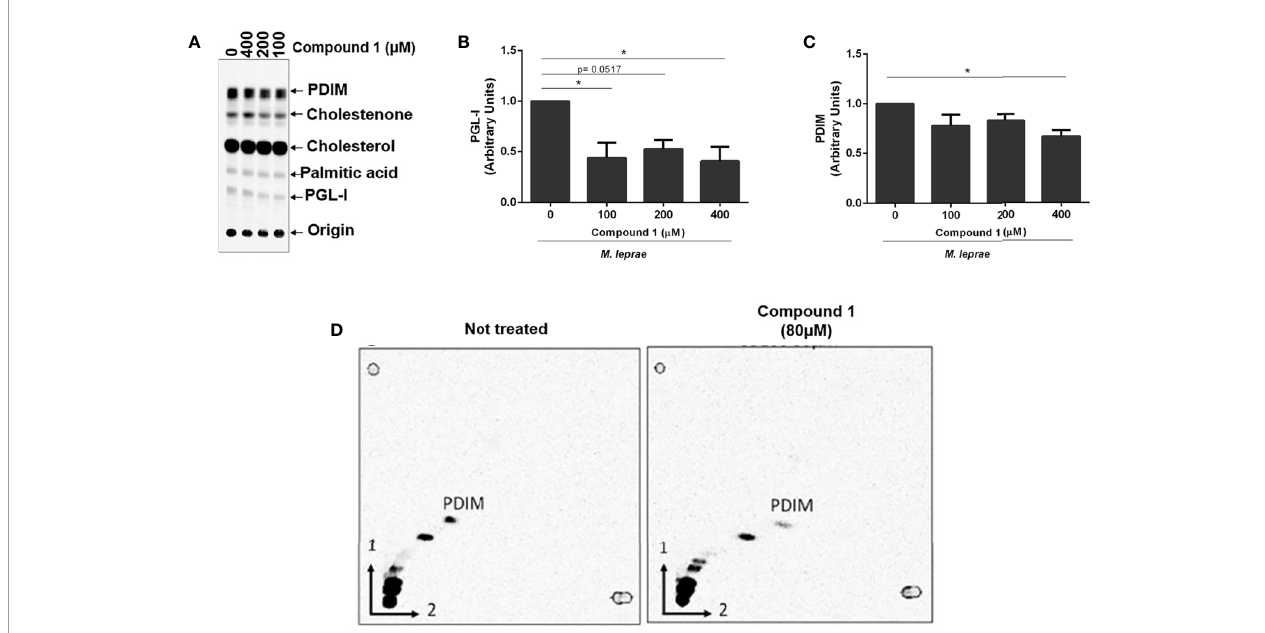
FIGURE 5 | Reductive power generated by 3 b -HSD supports PGL-I and PDIM synthesis. (A) TLC of lipid extracts from M. leprae treated with compound 1, representative of 4 experiments. TLC was resolved using chloroform-methanol 95:5 (v/v) as mobile phase. Standards: PDIM, cholesterol; cholestenone; palmitic acid and PGL-I. Corresponding densitometry of PGL-I (B) and PDIM (C) (*p < 0.05 - ANOVA test followed by Bonferroni post-test were performed for statistical analyses (n=4). (D) To con fi rm the apolar product labeled as PDIM in (A) was truly PDIM, 2-dimensional TLC analyses of the lipid extract from M. leprae treated or not with 80 µM compound 1 was